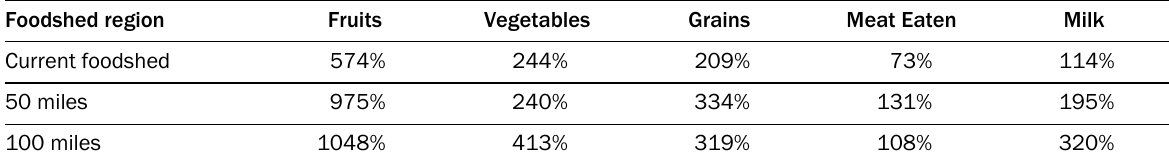
Table 10. Proportion of Produced Food Consumed by Each Foodhsed’s Entire Population* Foodshed region